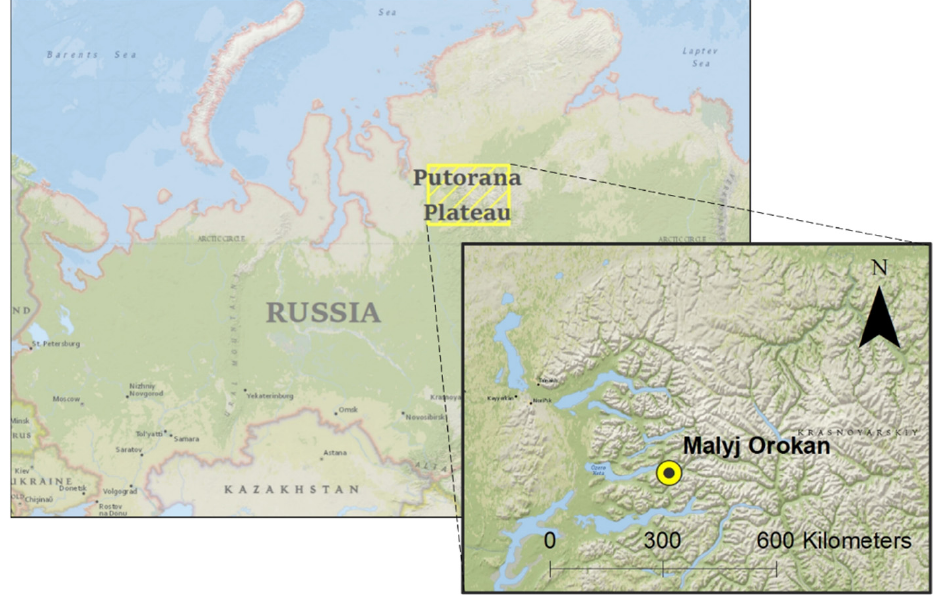
Figure 1. Location of the study site in the Putorana Mts, near Keta Lake, Malyj Orokan River